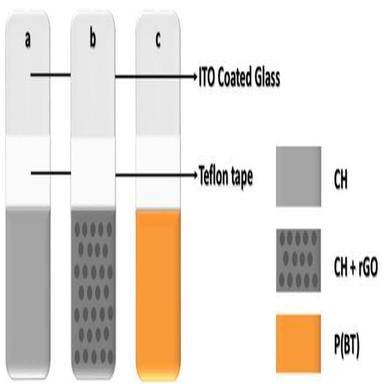
a) CH modified ITO, b) CH/rGO coated ITO and c) electrodeposition of p(BT) onto CH or CH/rGO modified ITO electrode.